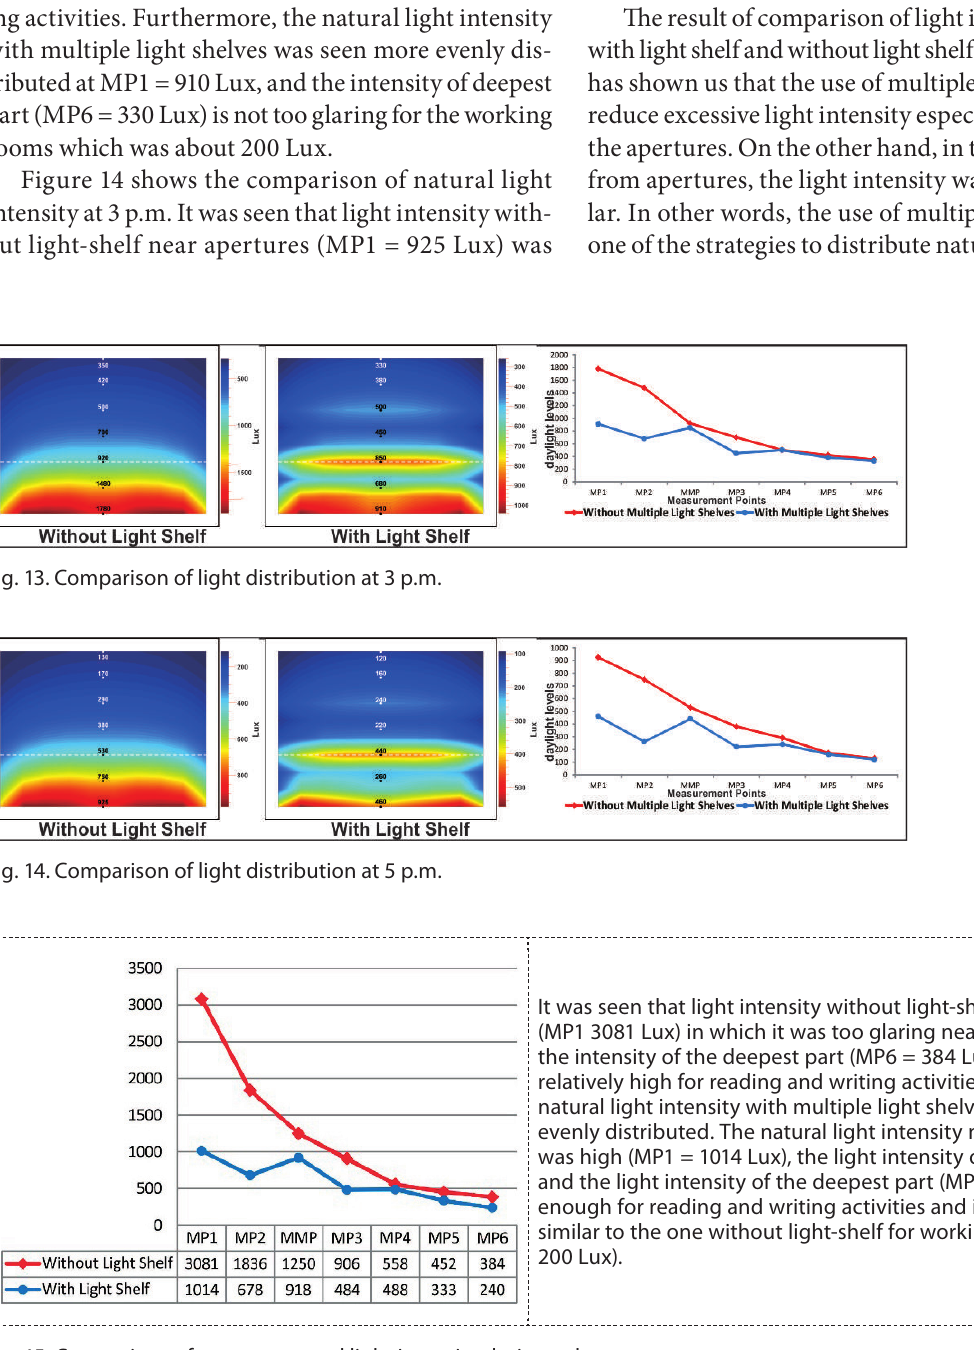
Fig. 15. Comparison of average natural light intensity during a